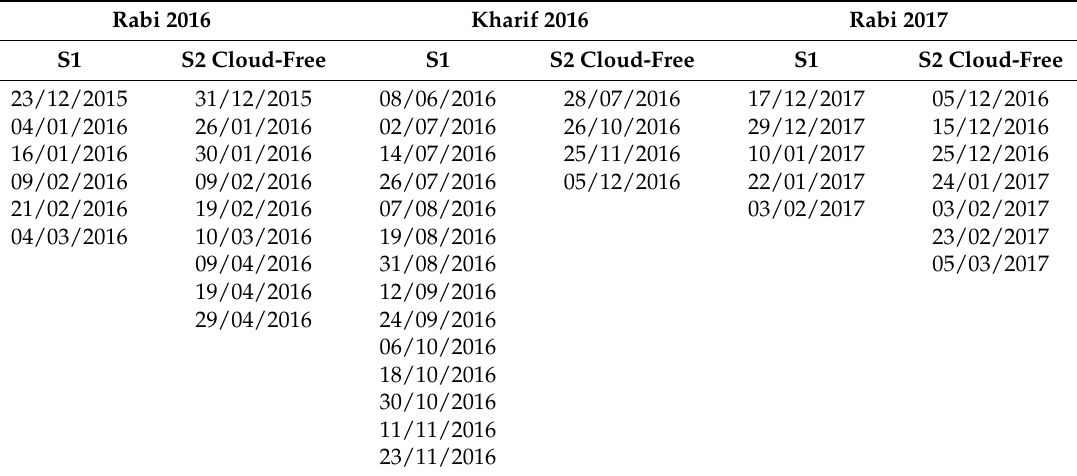
Table 1. List of acquisition dates of Sentinel images used for each growing